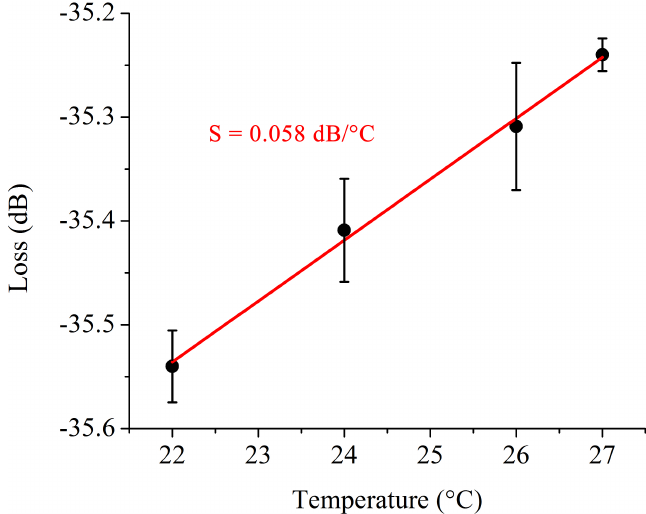
Figure 5. Fringe power measured as function of temperature variation at 1485nm wavelength